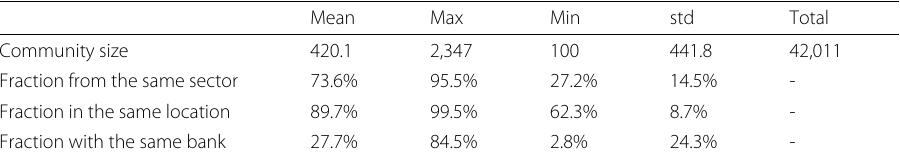
Table 2 Summary of the properties of the considered communities Mean Max Min std Total Community size 420.1 2,347 100 441.8 42,011 Fraction from the same sector 73.6% 95.5% 27.2% 14.5% - Fraction in the same location 89.7% 99.5% 62.3% 8.7% - Fraction with the same bank 27.7% 84.5% 2.8% 24.3%